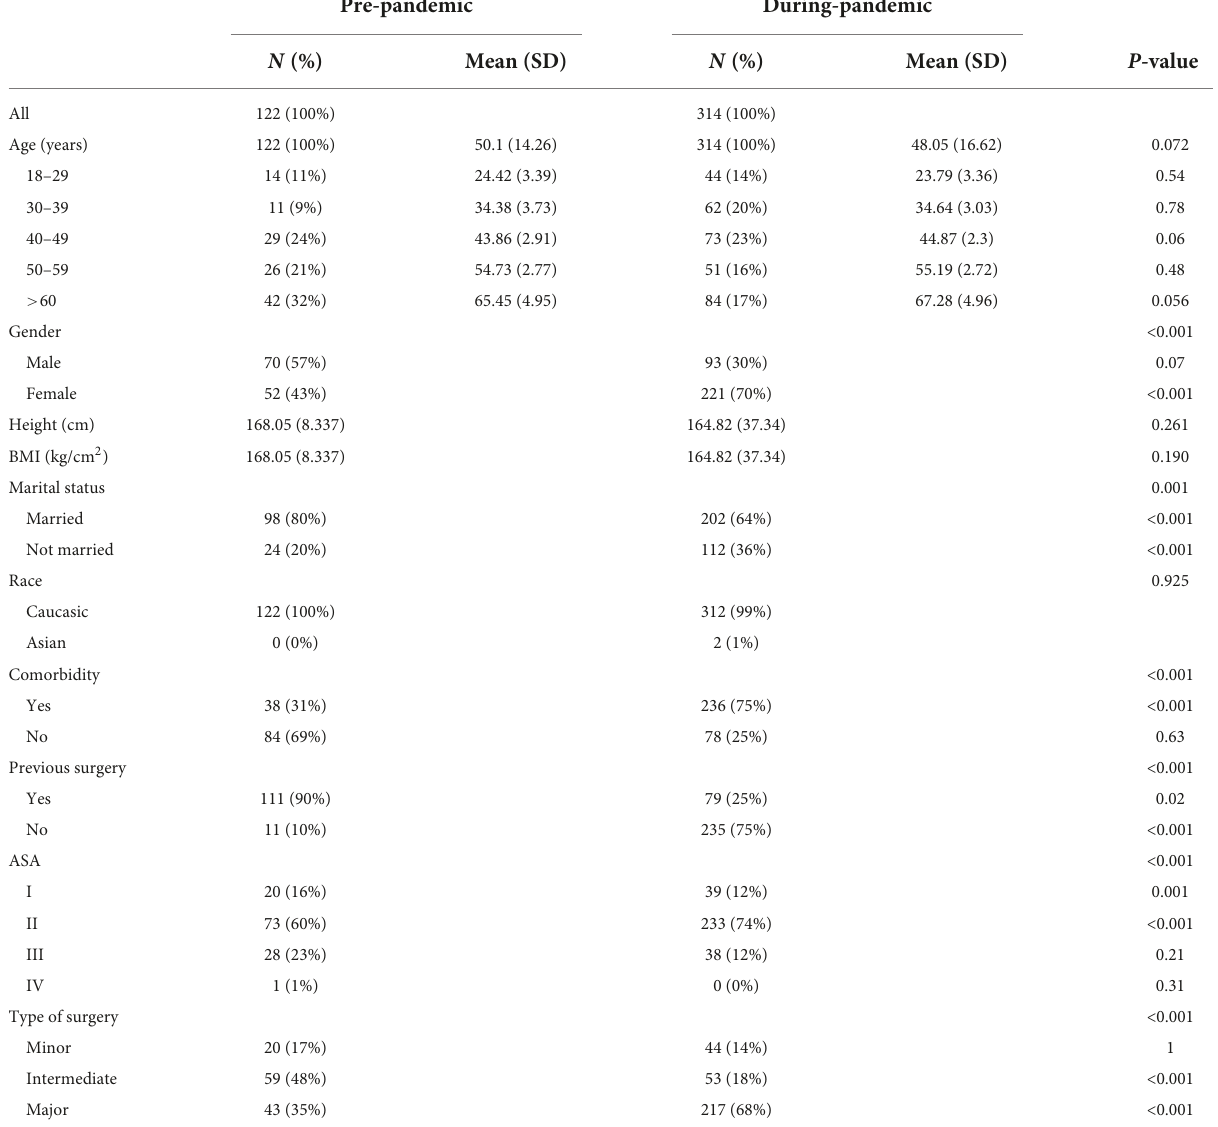
TABLE 1 Demographic characteristics of the study